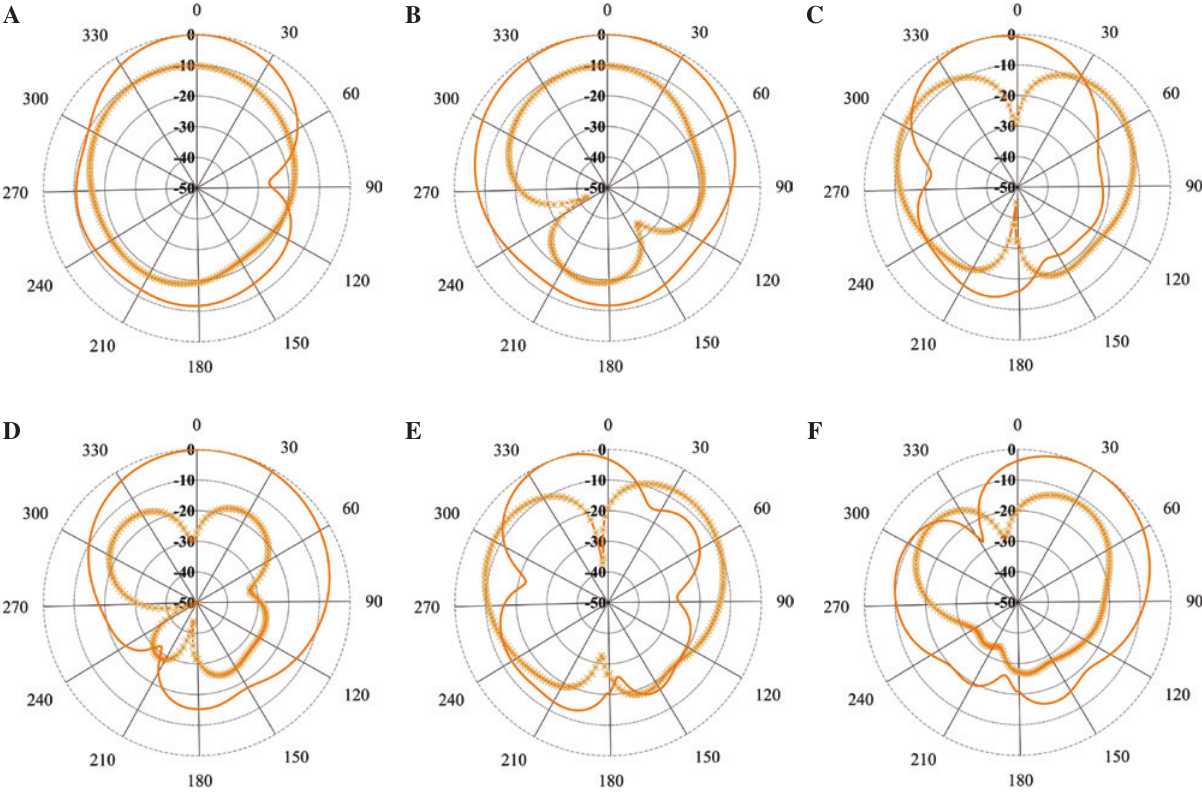
Figure 14: Measured radiation pattern: (A) E-plane at 3.7 GHz, (B) H-plane at 3.7 GHz, (C) E-plane at 7.3 GHz, (D) H-plane at 7.3 GHz, (E) E-plane at 9.2 GHz, and (F) H-plane at 9.2